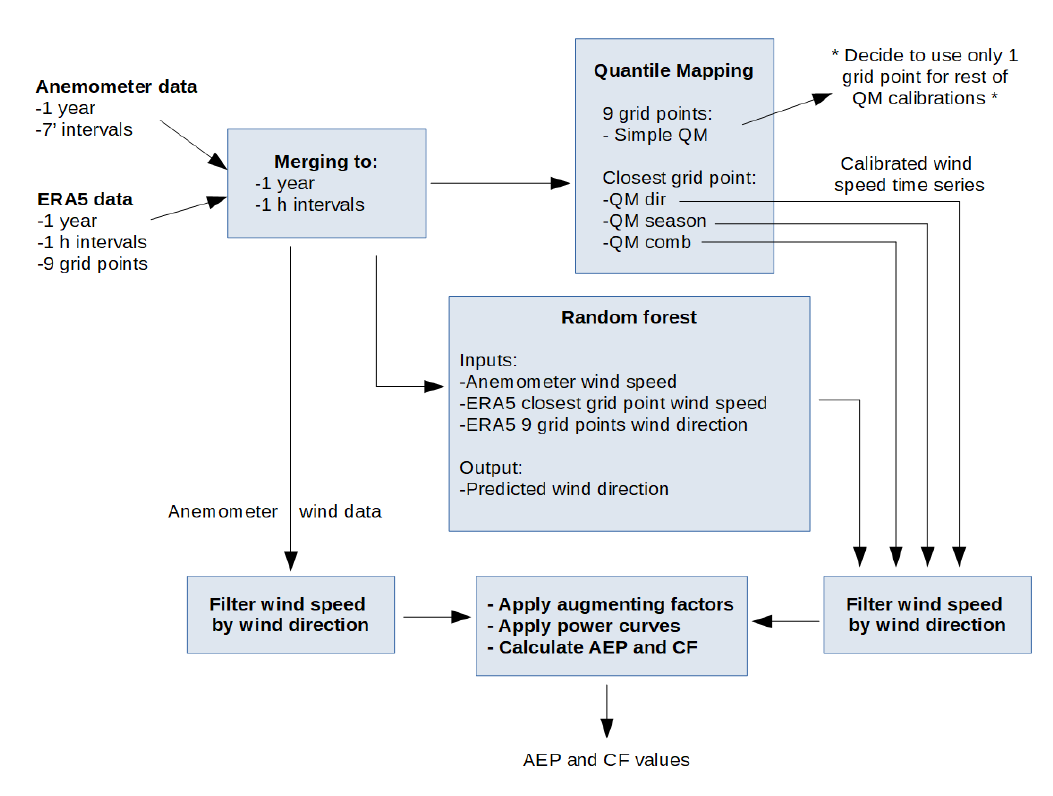
Figure 1. Diagram that summarizes the methodology and data